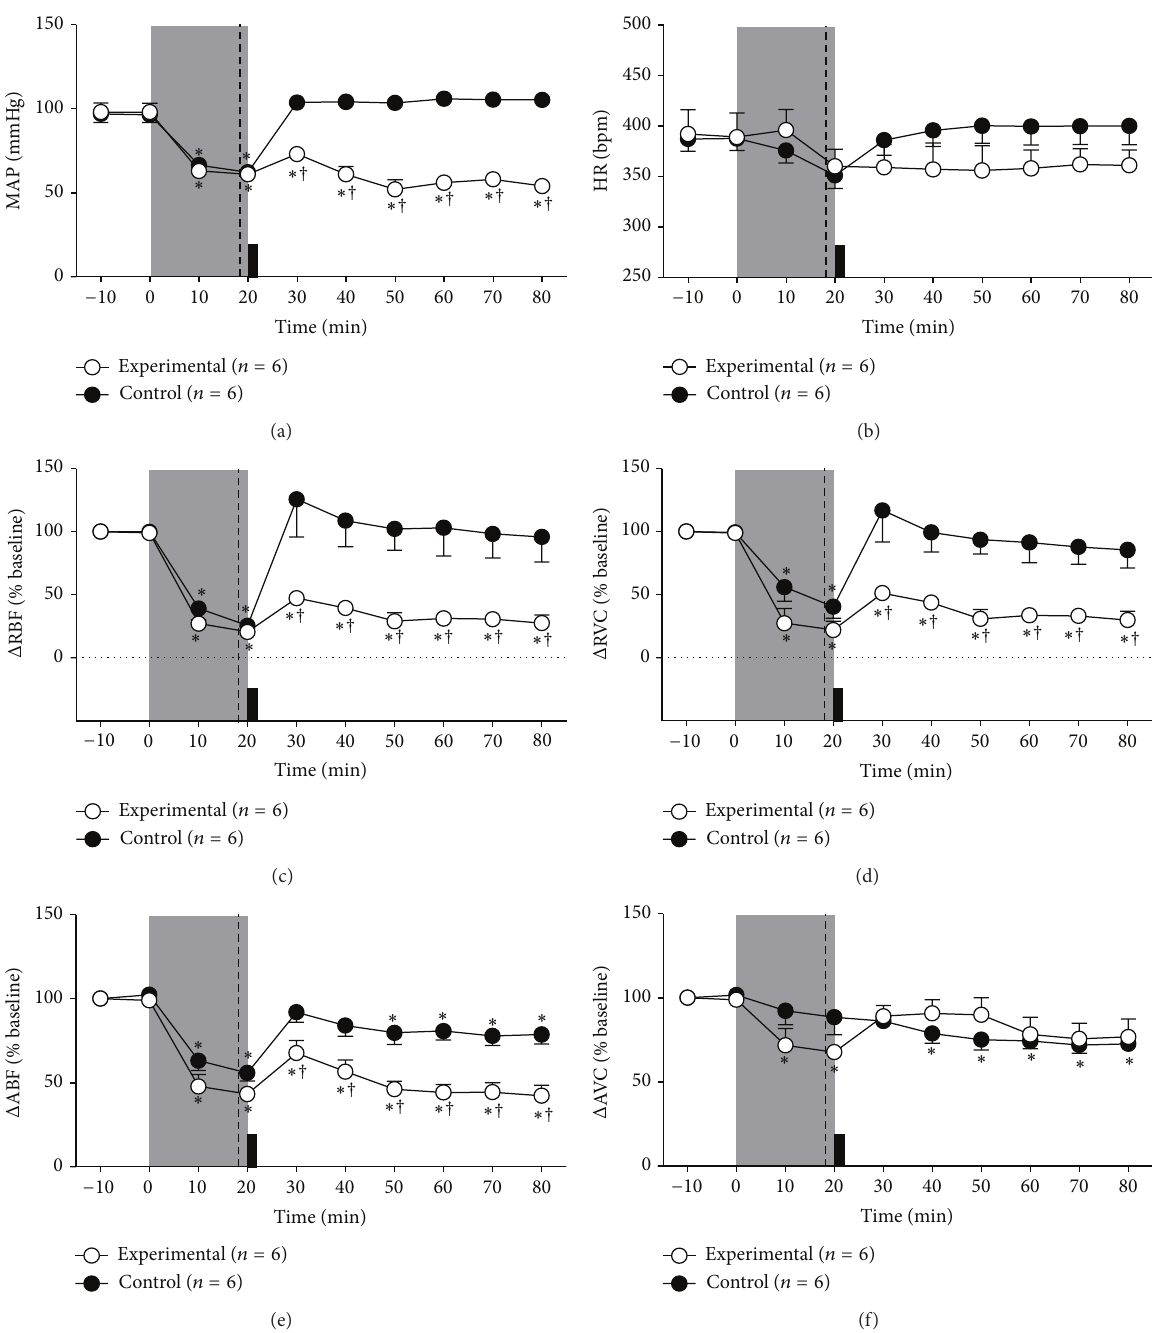
Figure 3: Effects of pharmacological blockade of the MnPO on changes in mean arterial pressure (MAP; (a)), heart rate (HR; (b)), variations of renal blood flow ( Δ RBF, % baseline; (c)), renal vascular conductance ( Δ RVC % baseline; (d)), aortic blood flow ( Δ ABF, % baseline; (e)), and aortic vascular conductance ( Δ AVC, % baseline; (f)) induced by sodium overload in the rats submitted to hemorrhage. Control group received nanoinjections of 150 mM NaCl ( 𝑛 = 6 ) and experimental group received nanoinjections of 4mM Muscimol ( 𝑛 = 6 ) groups. Values were expressed as means ± S.E.M. ∗ Different from time 0; † different from control group with 𝑃 < 0.05 . Shaded area indicates the period of hemorrhage.DashedlinerepresentsthemomentofnanoinjectionintotheMnPO(muscimolorvehicle)andblackblockindicatesintravenous hypertonic saline